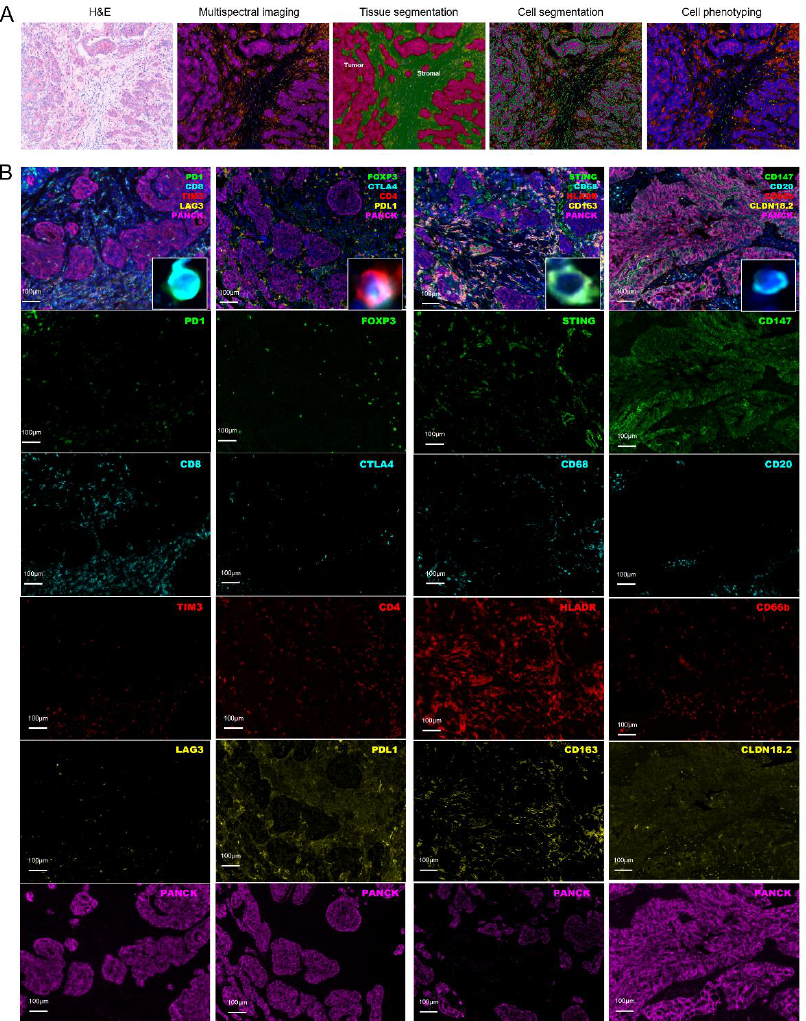
* Percentage indicates the proportion of patients with a specific clinical, pathologic, or molecular characteristic among all patients. Abbreviations: dMMR, deficient mismatch repair; pMMR, proficient mismatch repair. 3.2. Blood Indexes Were Associated with Immune Cell Concentrations in Primary Tumor